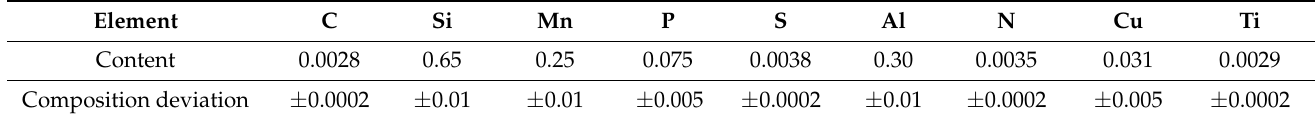
Table 1. The composition of Fe-0.65%Si non-oriented electrical steel in CSP process (wt